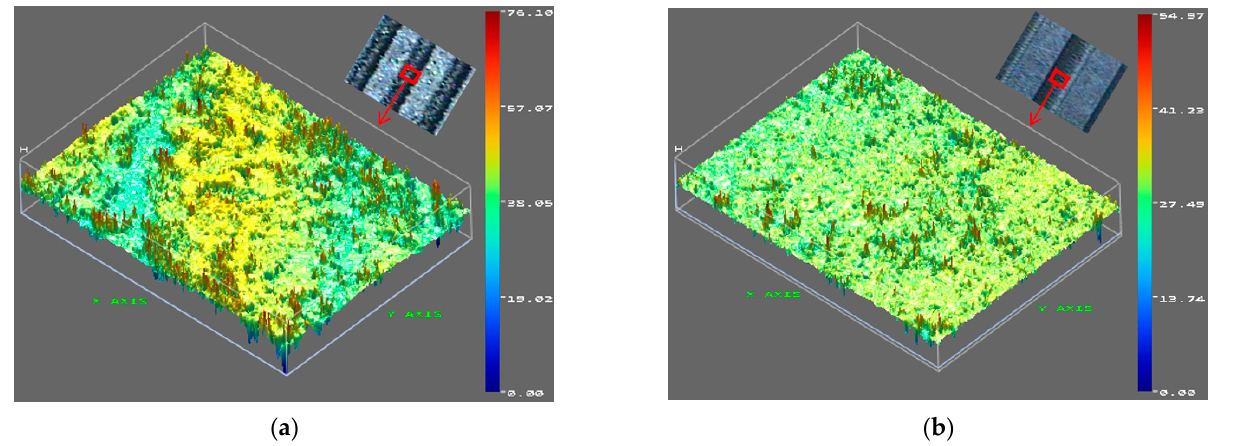
Figure 10. Three-dimensional surface profile at channel: ( a ) PBF-built SUS 316L BP(W0.29, R0.31, and D0.57); ( b ) CNC-machined graphite BP (W0.94, R0.94, and D1.0).